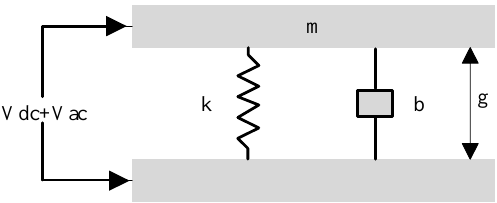
Figure 2. Parallel plate capacitance model (transmitted).